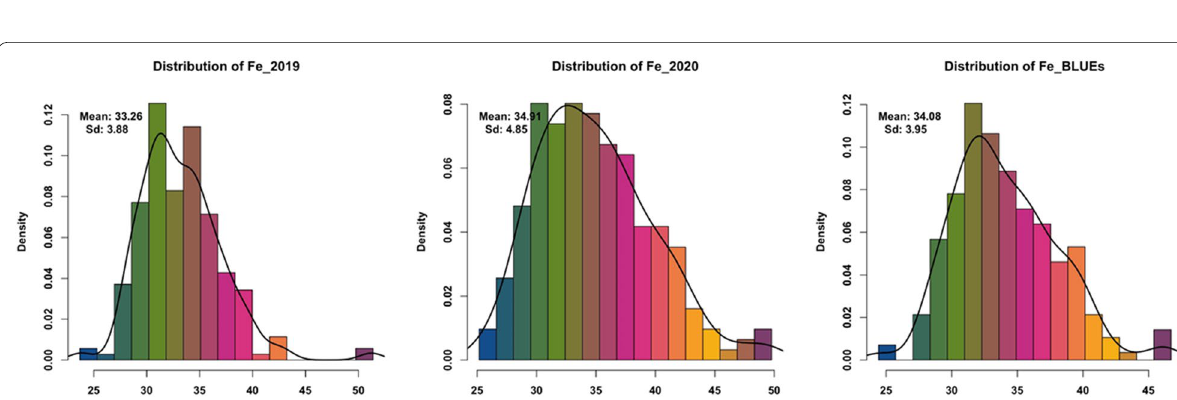
Fig. 3 Distribution of phenotypic data in all genotypes for Fe concentration for each year (2019/2020) and BLUEs in spring barley